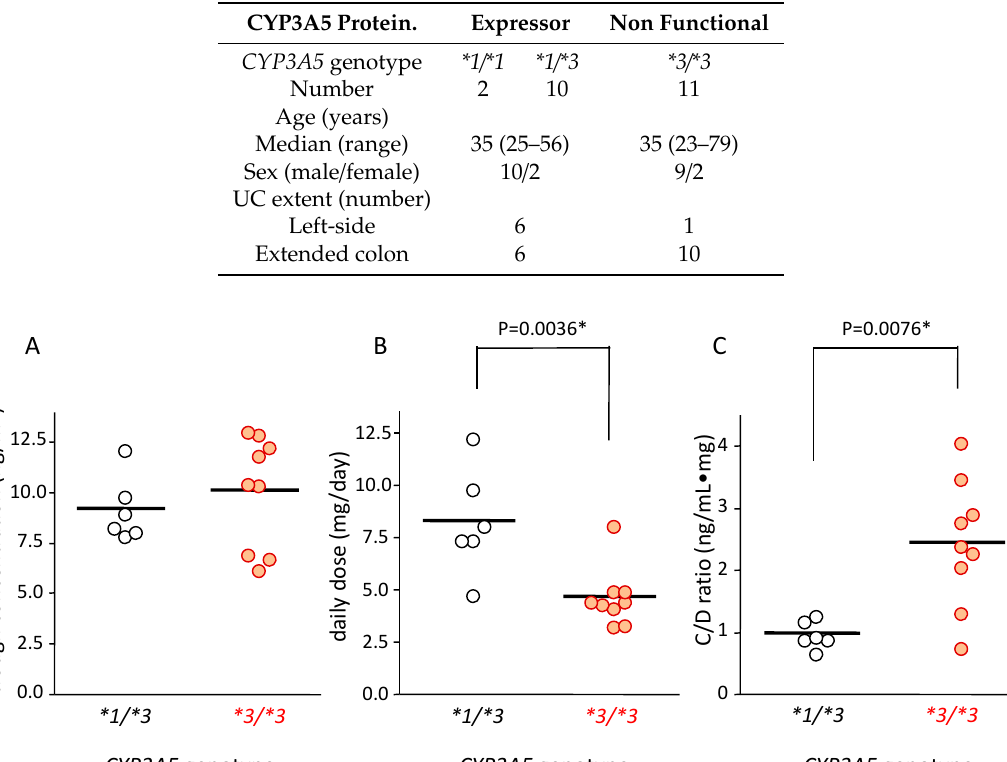
Table 2. Patients characteristics based on CYP3A5 genotype.